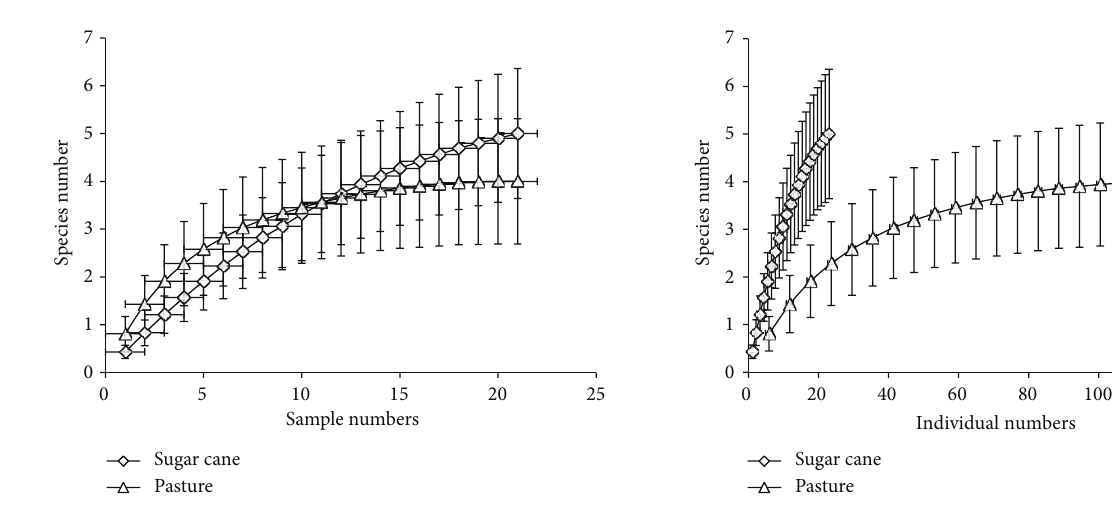
Figure 2: Sample-based rarefaction curves of terrestrial amphibians in fragments of Semideciduous Seasonal Forest with three predom- inant matrix types (sugar cane and pasture), estimated from 500 randomizations in the order of the samples.